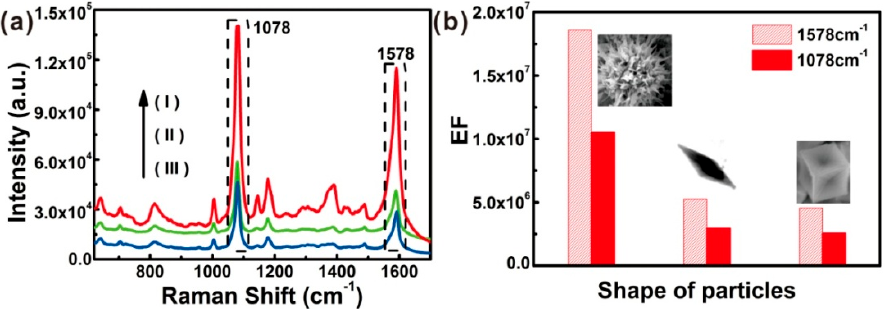
Figure 9. ( a ) The Raman spectra of the different substrates after dropping 20 μ L 10 − 5 M 4-ATP ethanol solution and drying. The objective was 50× telephoto, laser power was 2 mW, and the acquisition time was 5 s. Curves (I), (II), and (III) correspond to the films built of the chestnut-like Au nanocrystals, the Au nanospindles, and the concave Au nanocubes, respectively. ( b ) Enhancement factors at the peaks at 1078 cm − 1 and 1578 cm − 1 for the different Au nanocrystal-built films. For quantitative analysis of the SERS activity or effect for these Au nanocrystals, enhancement factor (EF) was calculated in accordance with Formula (4)